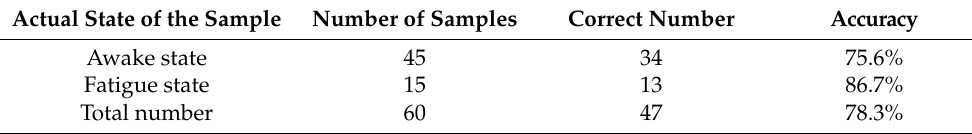
Table 3. Fatigue test results of scenario 2 according to the BP neural network model. Actual State of the